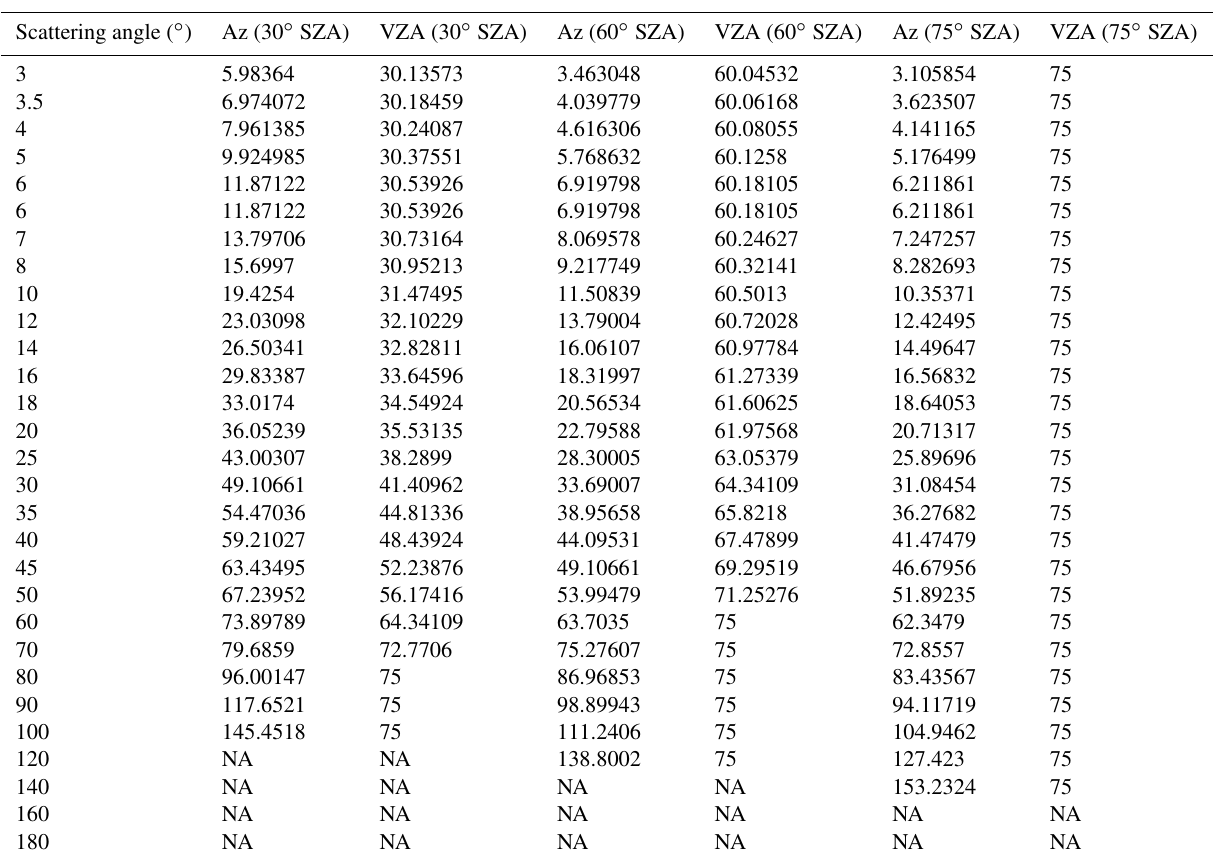
size distribution for both modes, IRI at four standard wave- lengths, SSA at four standard wavelengths, and asymmetry parameter at four standard wavelengths. The uncertainty es- timates for the real part of the refractive index (RRI)